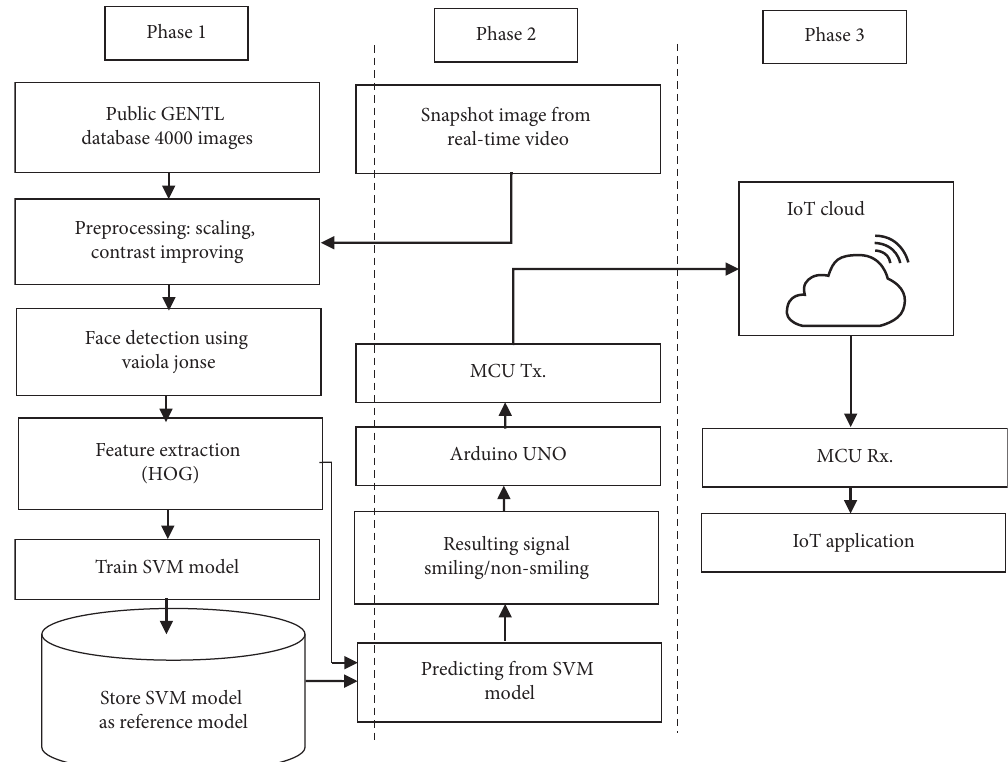
Figure 1: Block diagram illustrates the methodology of the proposed